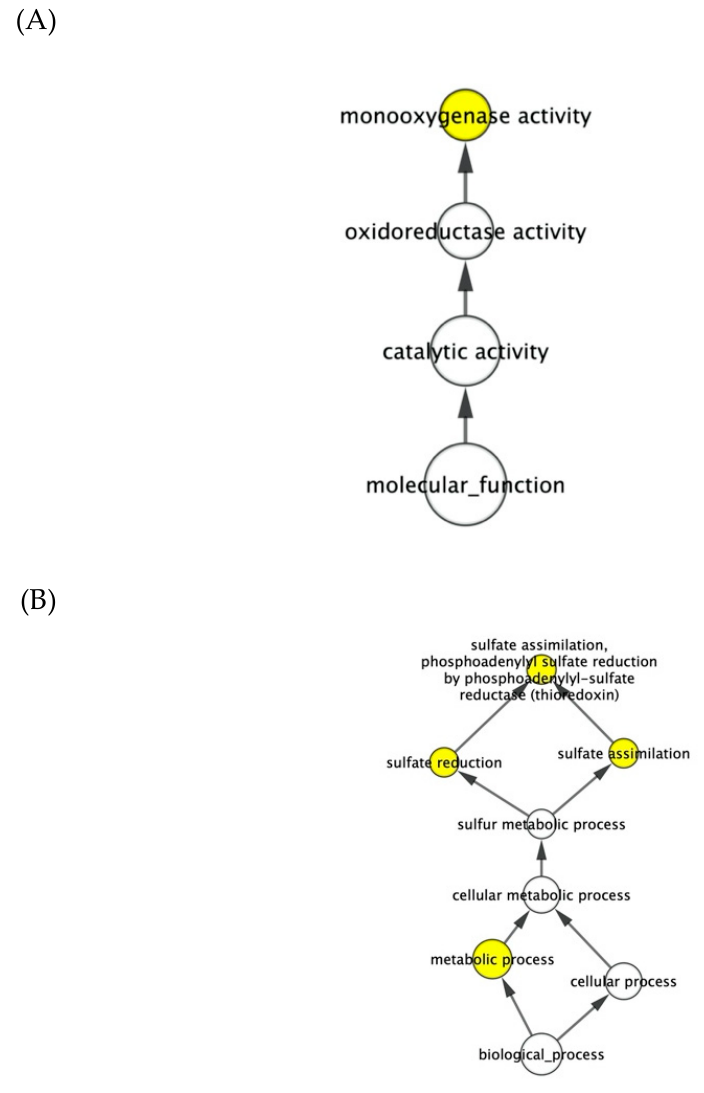
Figure 2. Enriched GO terms (colored in yellow, adjusted p value < 0.05) for ( A ) up-regulated and ( B ) down-regulated DEGs identified in the Wz-Wz isolate using BiNGO. Table 5. Enriched KEGG pathways in the Wz-Wz and Wz -H isolates of P. nicotianae on K 326 Wz/Wz . Isolate DEG Regulation Term Rich-Factor Corrected p